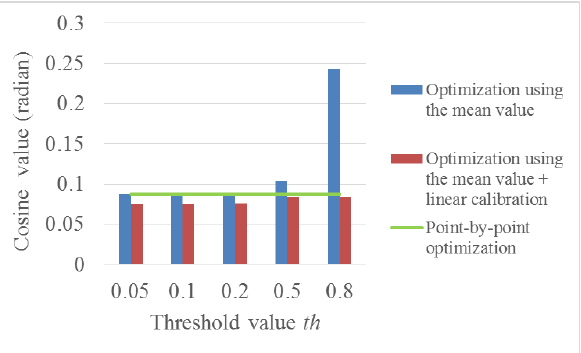
Figure 4. Spectral similarity between reference spectra and recovered spectra using different thresh- olds during reconstruction.